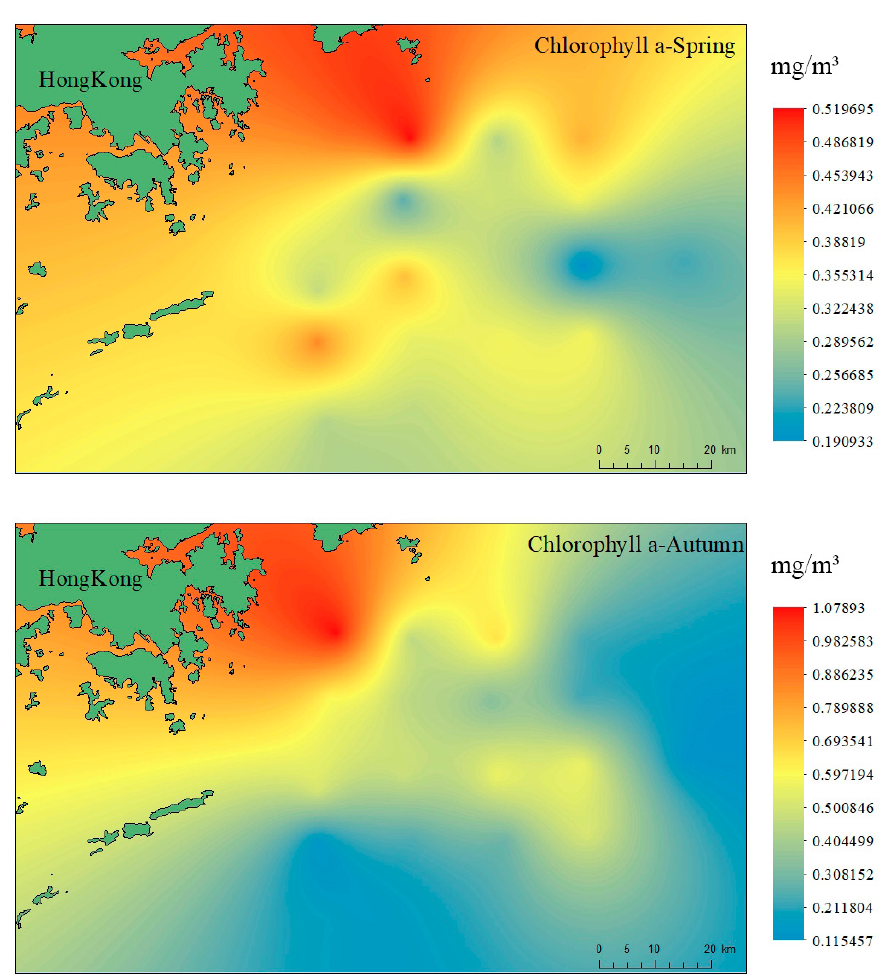
Figure 4. Results of chlorophyll a measurement in coastal region of Hong Kong. The results of the Hong Kong Coastal Species Diversity Index are shown in Figure 5. age density of 174.472 × 104 cells/m 3 . The number of phytoplankton was dominated by diatoms, with a density of 165.452 × 104 cells/m 3 , accounting for 94.83% of the total den- sity. In the spring survey, the average number of phytoplankton species was 30, and the species diversity index ranged from 2.96 to 3.63, with an average of 3.30. In September 2018, the density level of phytoplankton in autumn was not significantly different from that in spring. The average number of phytoplankton species in the station quadrats in autumn was 32, and the species diversity index was between 2.85 and 3.62, with an aver- age of 3.36, slightly larger than that in spring.